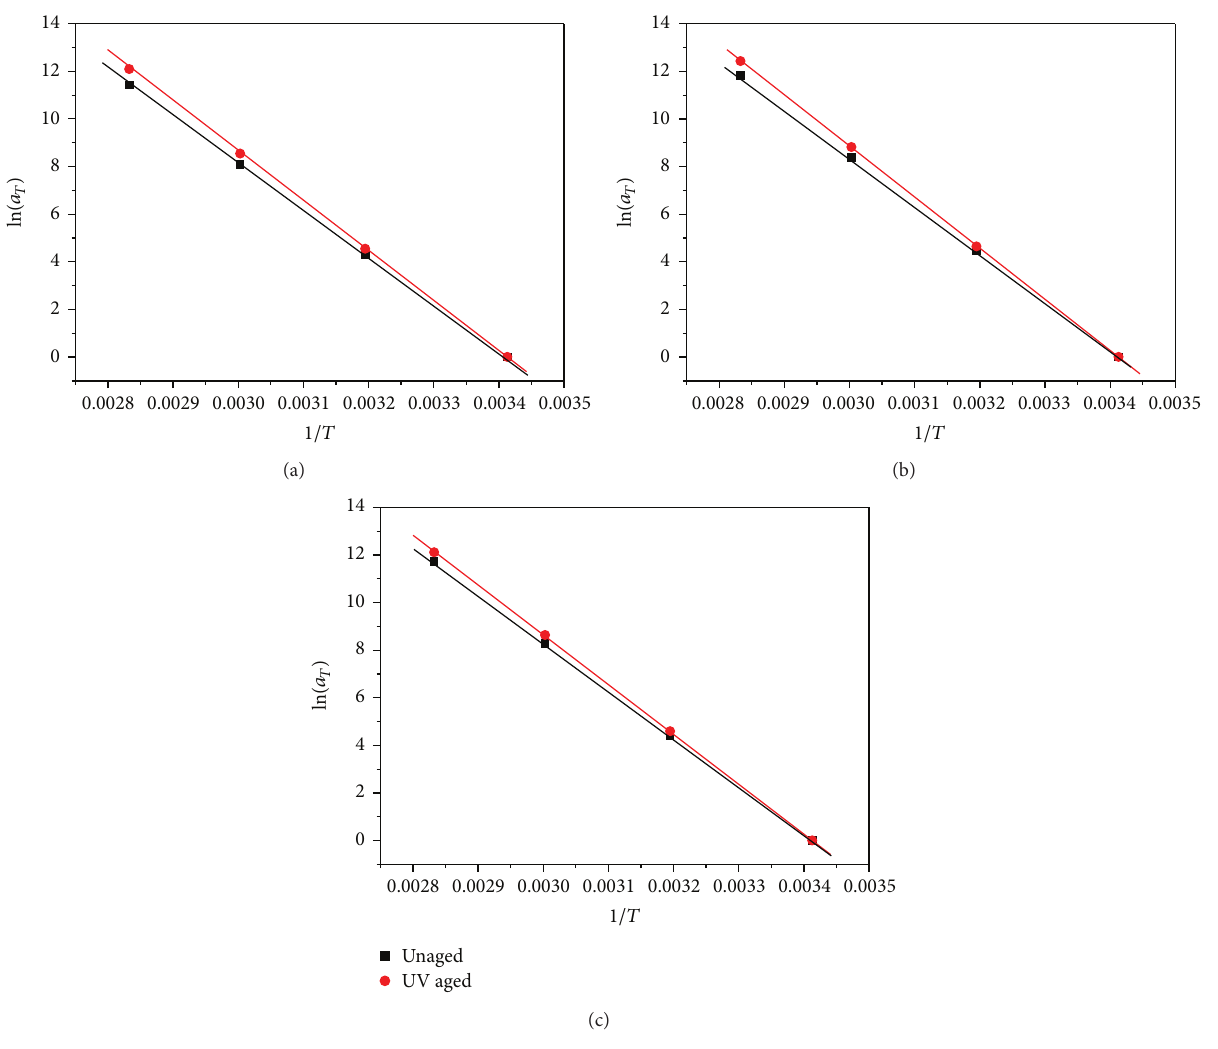
Figure 13: Arrhenius fitting plots of complex modulus. (a) SBS modified asphalt, (b) Zn/Al-CO 32− -LDH/SBS modified asphalt, and (c) Zn/Al-HNOB − -LDH/SBS modified asphalt. Table 5: 𝐸 𝑎 in complex modulus of asphalts during UV aging